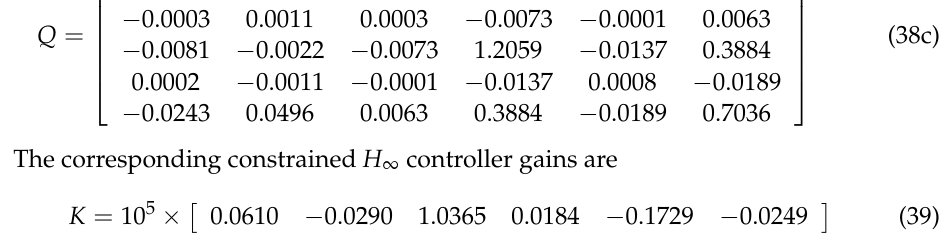
Table 1. The parameters for the active suspension system. Parameter